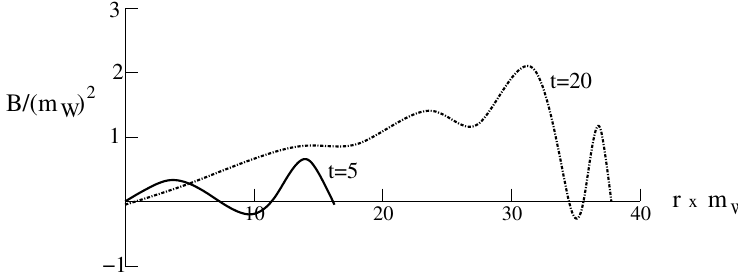
Figure 4. Final Magnetic fields created for two different t as a function of the W mass. The B field at the end of the EWPT, with the temperature= T c , was found to be B EWPT ( T c ) = 10 M 2 with M W = 80 GeV. W B EWPT ( T c ) is needed for the estimates of gravitational